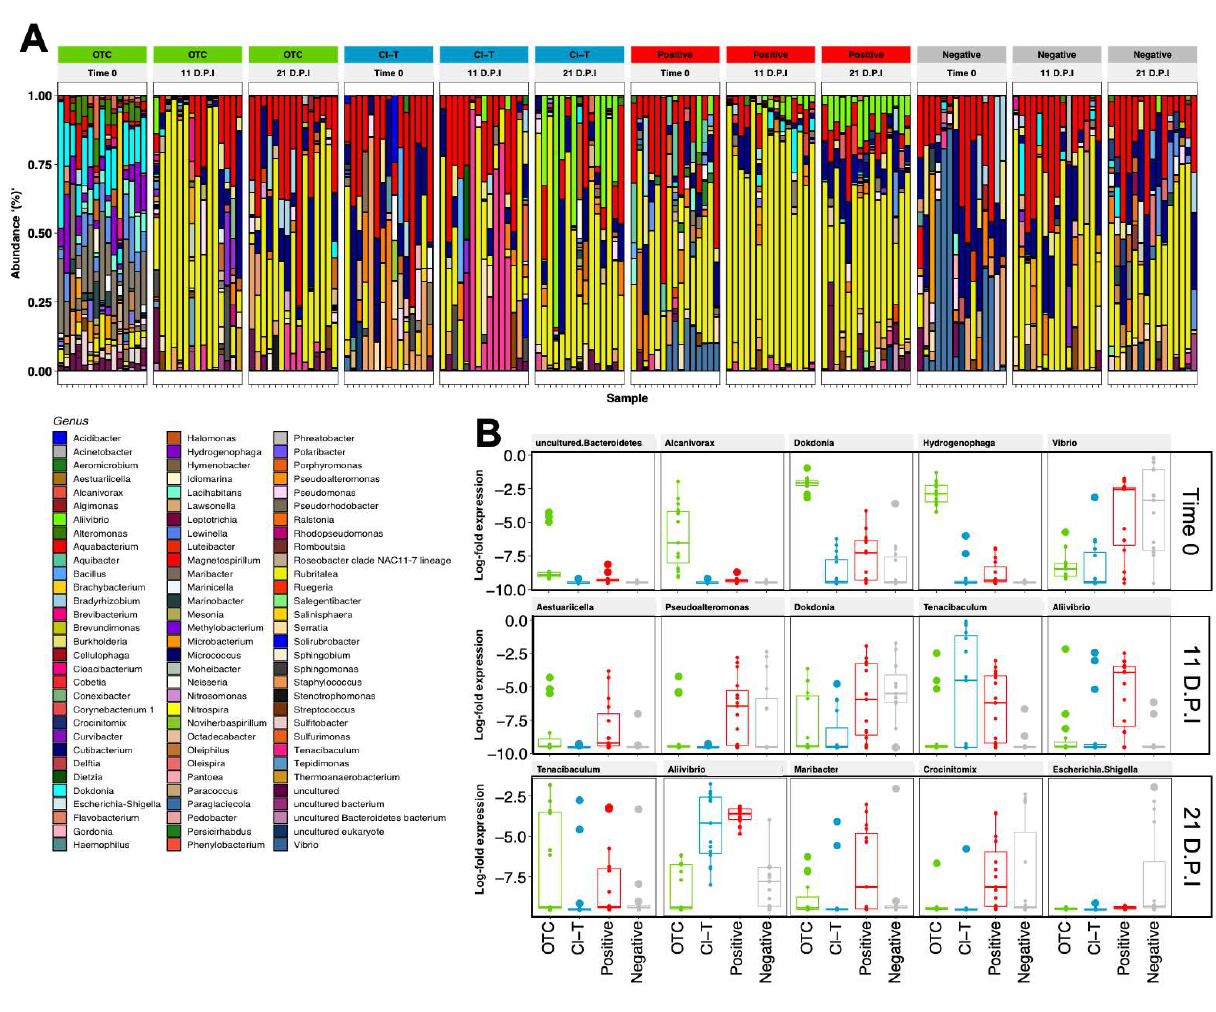
Figure 5. ( A )-Relative abundance of the top 93 genera assigned to fish gill mucus samples at three timepoints. Each bar represents one fish gill sample for the respective treatment group. ( B )-Differentially expressed ( padj < 0.01) taxa between treatment groups within each of the three measured timepoints. Top 5 taxa are ranked based on ASV importance (ascending in significance level) and expressed as log2 fold differences. The AGD positive treatments showed higher abundance of Aliivibrio at 11 dpi and higher Tenacibaculum at both 11 dpi and